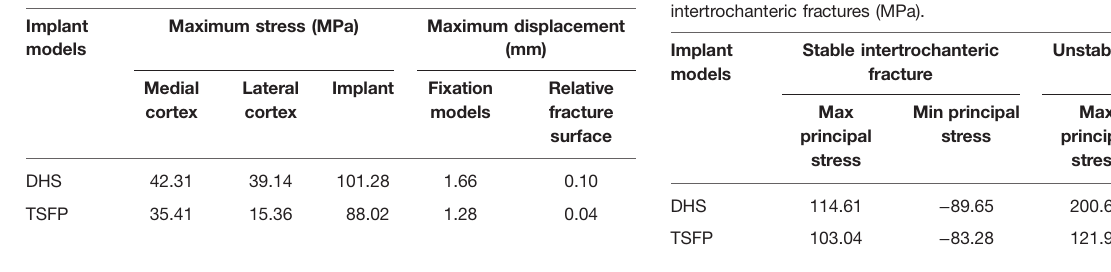
TABLE 3 | The maximum displacement and stress values of two implant models for the treatment of an unstable intertrochanteric fracture. Implant models